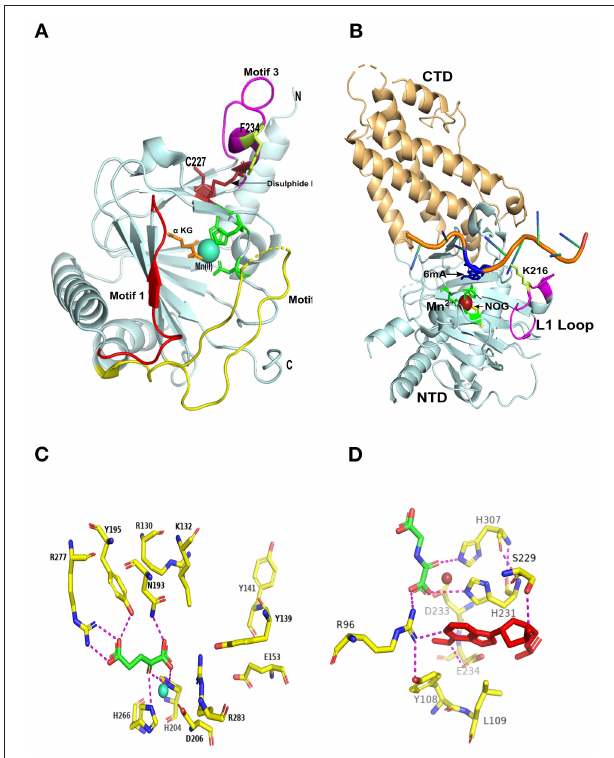
FIGURE 2 | Structural comparison between ALKBH5 and FTO. (A) Overall three-dimensional structure of ALKBH5 (PDB ID: 4NRO); the overall jelly-roll fold is colored in polycyan; the secondary recognition motifs-1, − 2, and − 3 are colored red, yellow, and magenta, respectively; disulfide bond depicted by an arrow; conserved HxD..H motifs are represented by green residues; motif-3 F234 is represented by limon residue; C227 is represented by firebrick residue; alpha-ketoglutaric acid ( α -KG) is represented by orange residue; manganese atom is represented by cyan circle. N: N-terminus, C: C-terminus. (B) Overall three-dimensional structure of FTO (PDB ID: 5ZMD); C-terminal domain (CTD) is colored polycyan; N-terminal domain (NTD) is colored light orange; unique loop (L1) is colored magenta; conserved HxD..H motifs are represented by green residues; K216 is represented by limon residue; 2-oxoglutarate analog (NOG) is represented by yellow residue; 6-methyladenine substrate (6mA) is represented by blue color; manganese atom is represented by firebrick circle. (C) ALKBH5 active site residues (PDB ID: 4NRO) (yellow carbon residues identified by their numbers); alpha-ketoglutaric acid ( α -KG) is represented by green carbon residue, attached by active site residues by magenta covalent bonds; manganese atom is represented by cyan circle. (D) FTO active site residues (PDB ID: 5ZMD) (yellow carbon residues identified by their numbers); 2-oxoglutarate analog (NOG) is represented by green carbon residue; and the 6-methyladenine nucleobase (6mA) is represented by red color attached to the active site residues by magenta covalent bonds; manganese atom is represented by firebrick